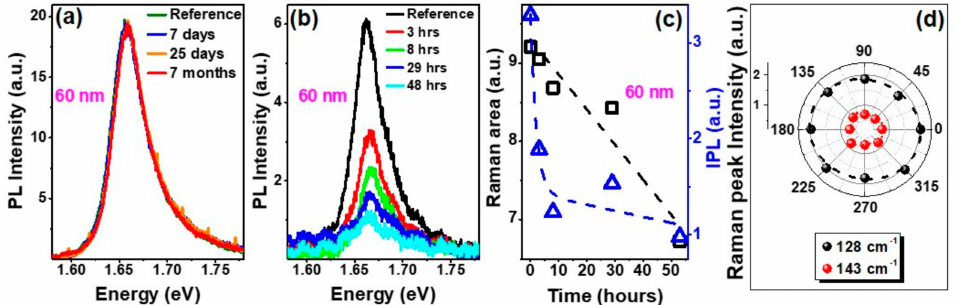
Figure3. Roomtemperaturephotoluminescence(PL)spectraofmechanicallyexfoliated( a )HSQ-capped and ( b ) uncapped 60 nm-thick GaTe flakes; ( c ) 115 cm − 1 Raman peak area (black) and integrated PL peak area (blue) plotted with respect to time for the uncapped 60 nm sample shown in (b); ( d ) Incident laser polarization dependence of the Raman peak intensity at 128 cm − 1 and 143 cm − 1